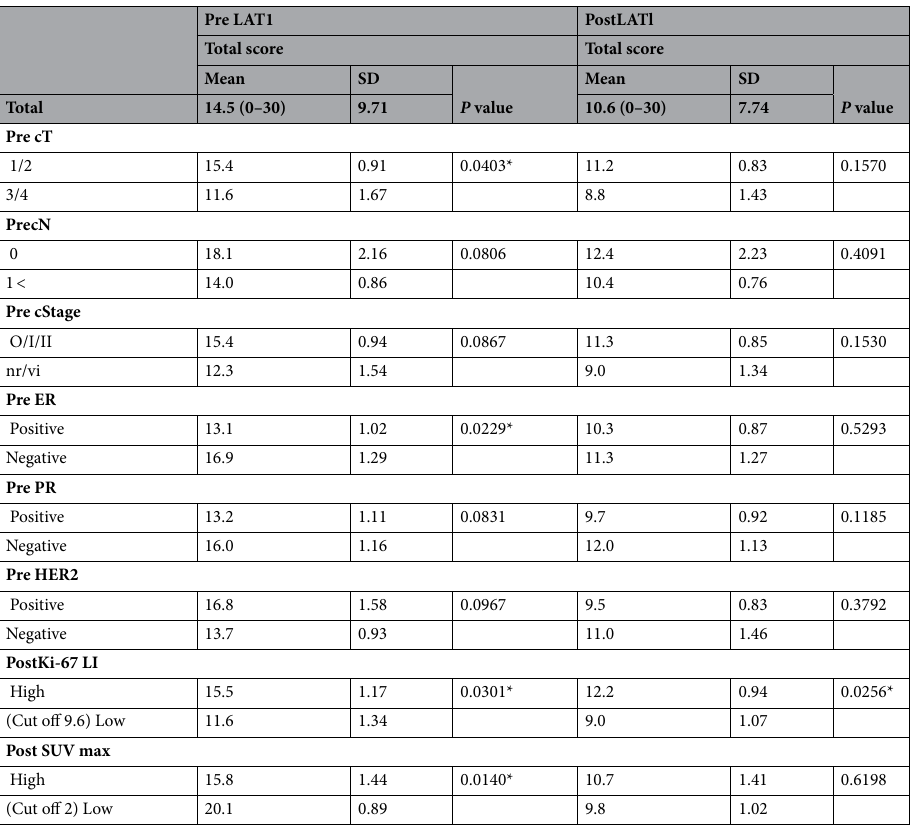
Table 2. Clinicopathological factors with the status of LAT1 (n = 143). LAT1, L-type amino acid transporter-1, SLC7A5; ER, estrogen receptor; PR, progesterone receptor; HER2, human epidermal growth factor receptor-2 ; SUV, standardized uptake value. The cutoffs of Ki-67 LI and SUVmax was defined as ROC curve of Pre LAT1 intensity score 2 < as